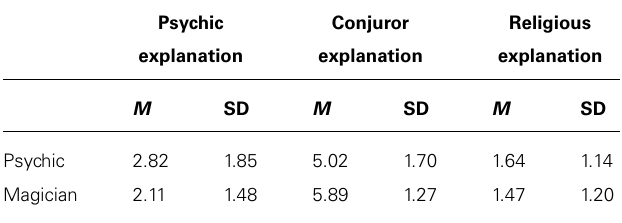
Table 1 | Mean psychic, conjuror, and religious explanation ratings ranging from 1 (strongly disagree) to 7 (strongly agree) for the psychic and the magician group separately.